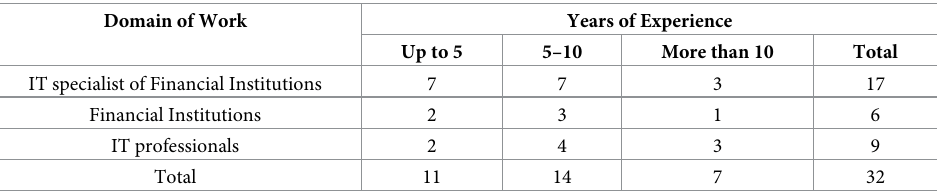
Table 2. The domain of